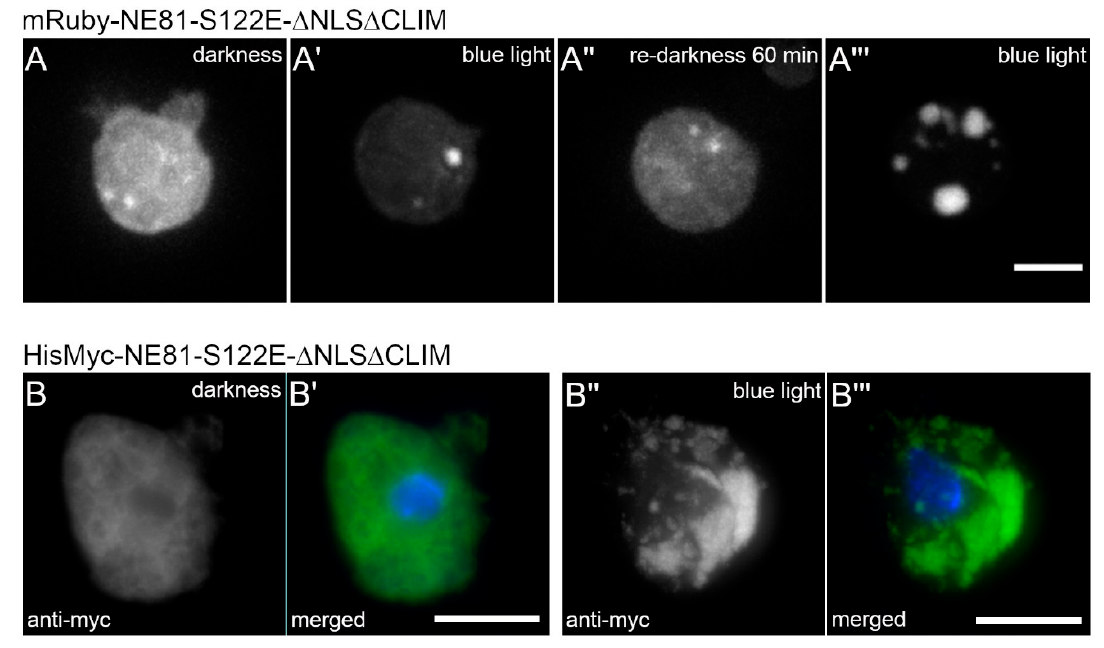
Figure 3. Blue light-induced assembly of NE81-S122E ∆ NLS ∆ CLIM is independent of the fusion tag. ( A – A”’ ) Selected time points of a spinning disk confocal live cell imaging with mRuby2-NE81-S122E ∆ NLS ∆ CLIM cells and excitation at 561 nm. Assembly was triggered by strong (40% AOTF transmission) exposure to 488 nm. ( A ) First recorded image after start of image acquisition; ( A’ ) the same cell after 3 min strong (40% AOTF transmission) exposure to 488 nm; ( A” ) the same cell after 60 min in the dark without 488 nm excitation; and ( A”’ ) the same cell after 3 min re-exposure to strong 488 nm laser light. Scale bar = 5 µ m. ( B – B”’ ) Expansion microscopy of fixed HisMyc-NE81-S122E ∆ NLS ∆ CLIM cells stained with anti-Myc / anti-mouse-AlexaFluor 488 and Hoechst 33342. Merged images ( B’ , B”’ ) show NE81-S122E ∆ NLS ∆ CLIM in green and chromatin in blue; ( B , B’ ) without light; and, ( B” , B”’ ) after blue light stimulation (band pass filter 450–490 nm). Expansion factors are 3.7 in ( B ) and 3.3 in ( B’ ), respectively; scale bar = 5 µ m (referring to the original size).